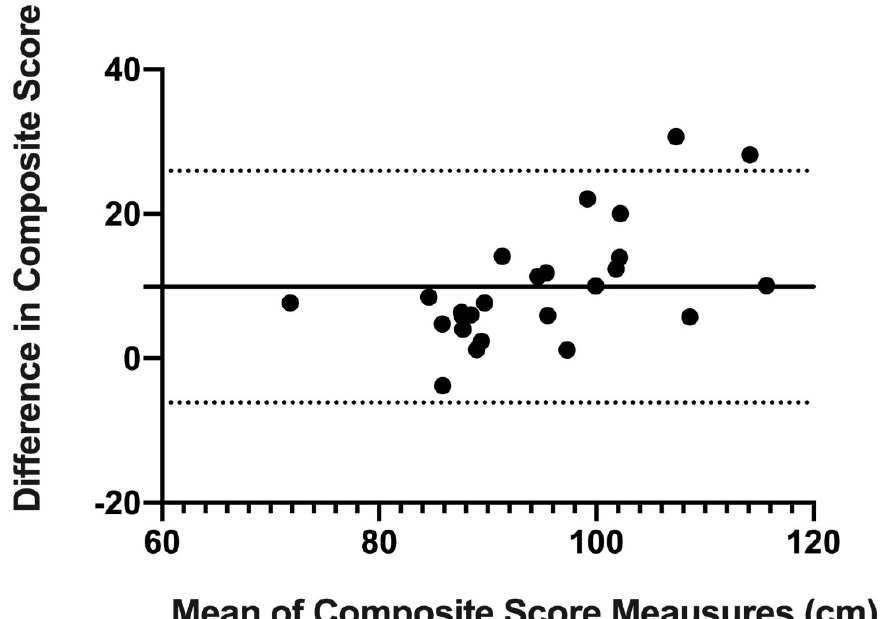
Figure 7. Bland–Altman right medial.